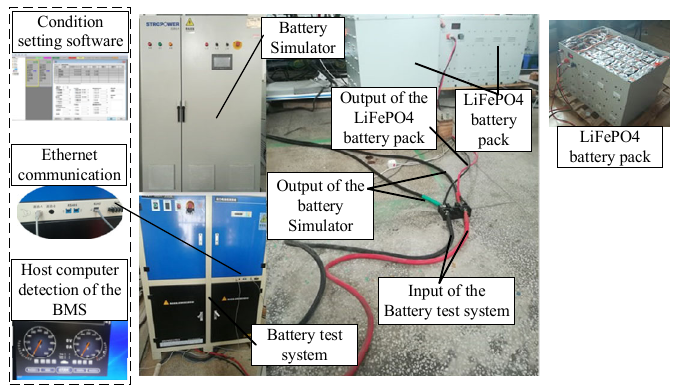
Figure 3. Experiment on the discharge characteristics of LiFePO4 battery.